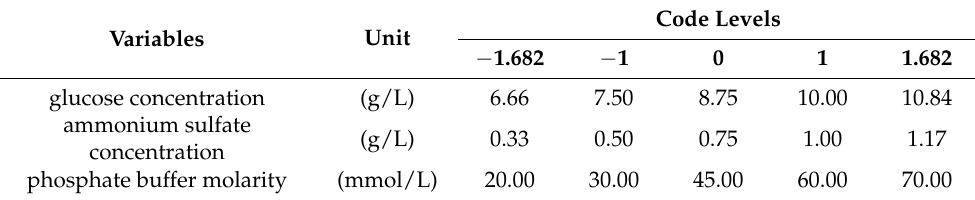
Table 1. Interpretation of coded levels of the three independent variables tested by